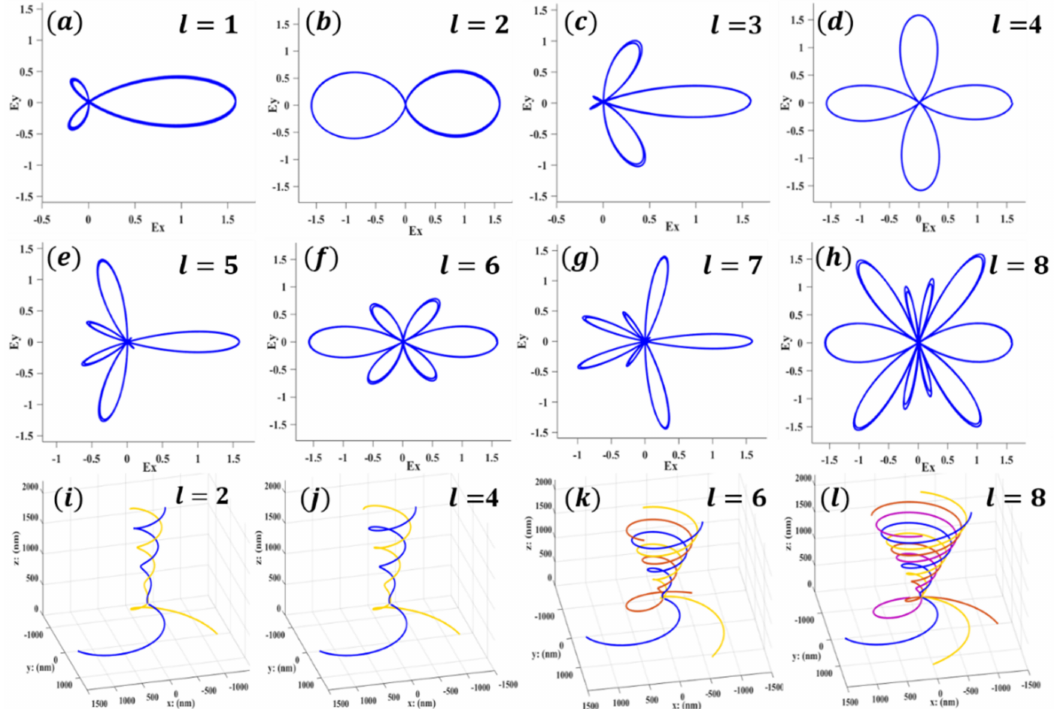
Figure 4. ( a – h ) Electric field distribution on the propagation cross section of optical vortex focal rings with different topological charges calculated according to our theory. ( i – l ) The propagation paths of optical vortices of different orders calculated according to the theory, and z = 0 is the upper surface of